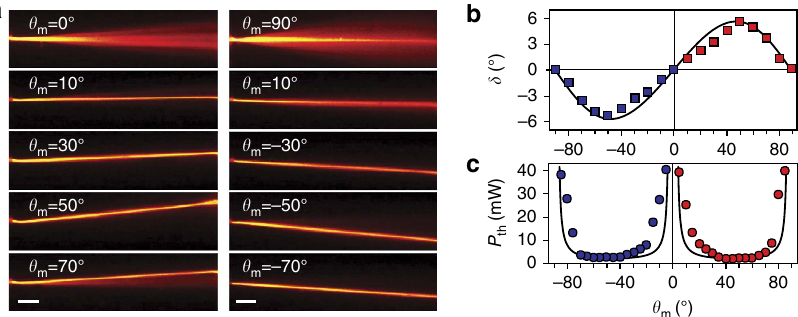
Figure 3 | Effect of magnetic field orientation on soliton trajectory. ( a ) Photographs of soliton trajectories in the fixed yz plane with walk-off determined by the magnetic field orientation y m . The white scale bar, 100 m m in each photograph. ( b ) Measured walk-off versus y m . The solid line is calculated from equation (1). ( c ) Threshold power for soliton formation versus y m . The solid line shows the qualitative trend P th ¼ P 0 /sin 2 y m , with P 0 ¼ 1.9mW. The blue and red markers in b , c correspond to the negative and positive walk-off angles in the yz plane, respectively.